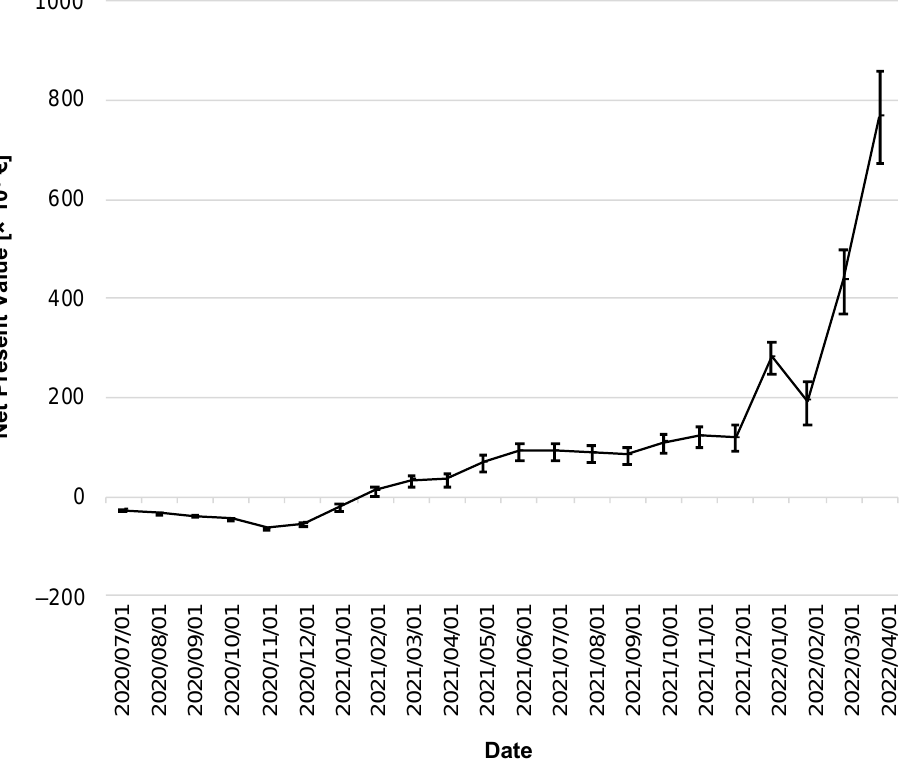
Table 2. Cumulative discounted costs and benefits over time.